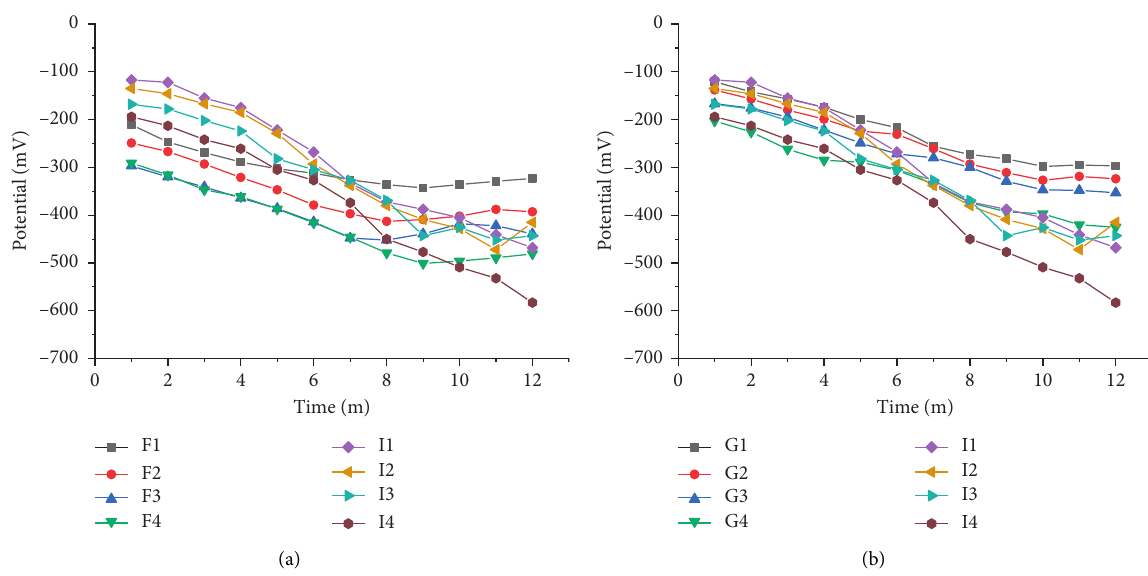
Figure 9: Potential of composite repair. (a) Potential of group F and group I. (b) Potential of group G and group I.